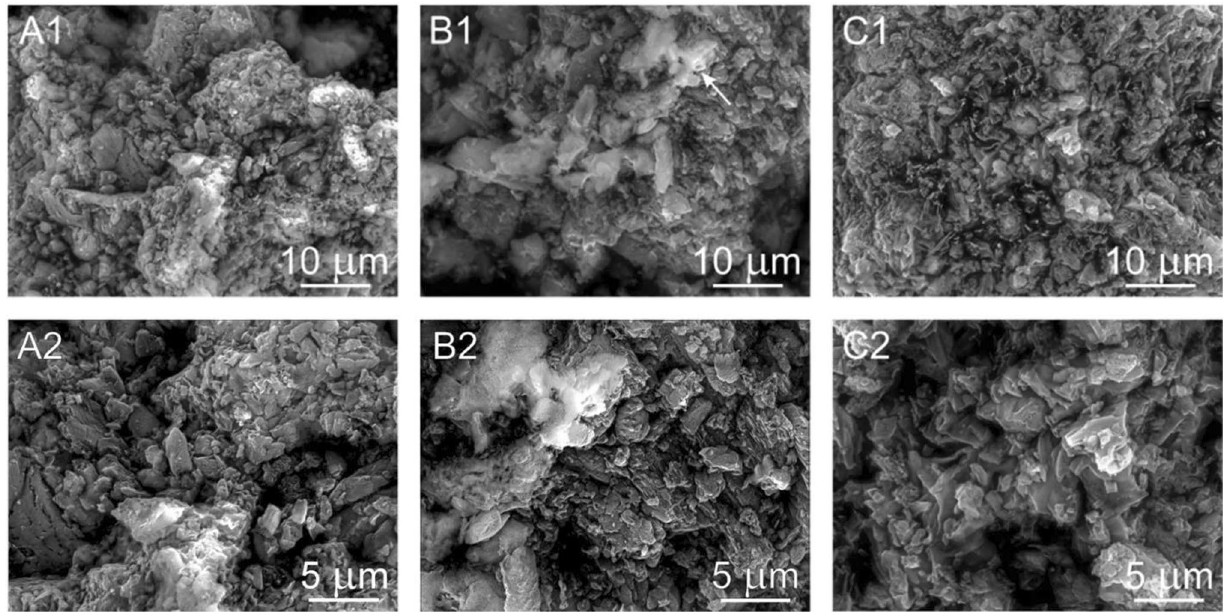
Figure 9. Micrographs (SEM:SE + BSE) of CN-D ( A1,A2 ), CN-M ( B1,B2 ) and CN-G ( C1,C2 ).